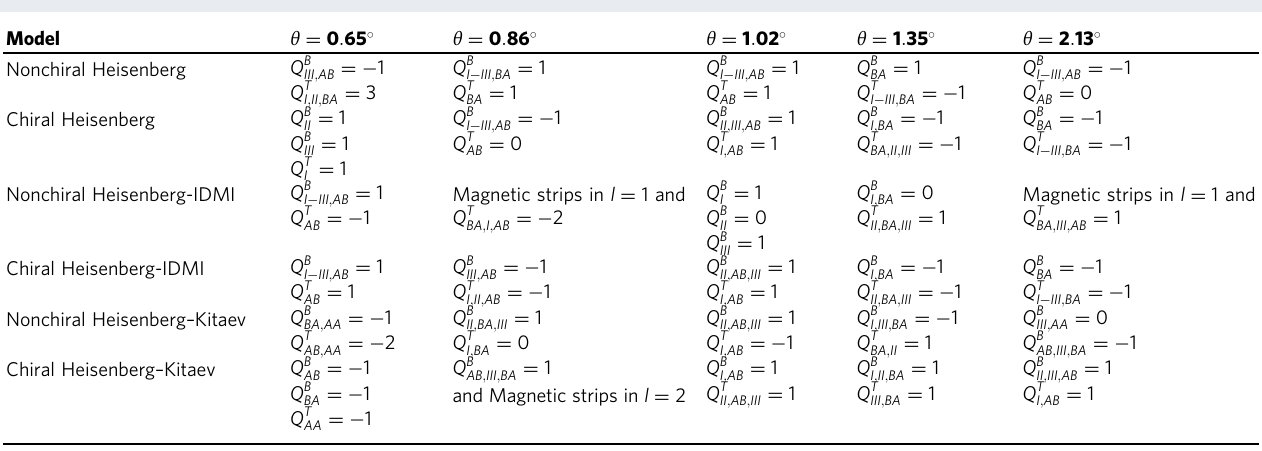
Table 3 Extended results on the spontaneous topological spin textures